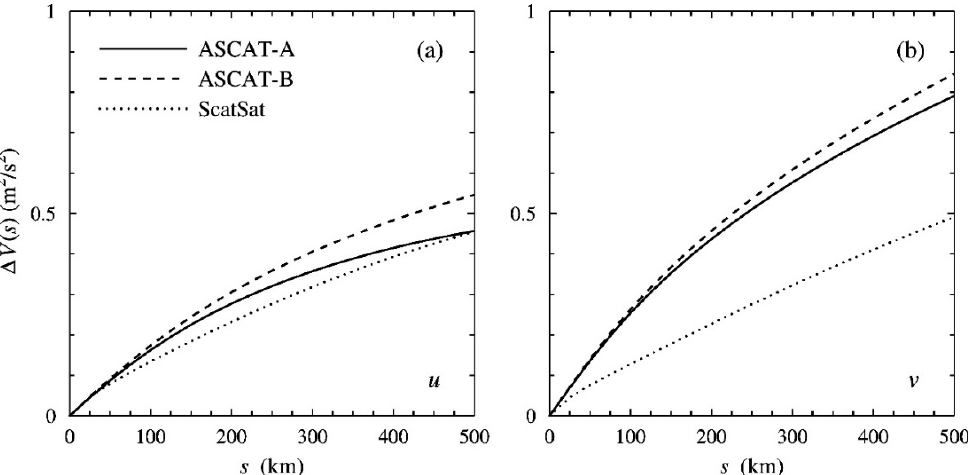
Figure 1. Difference between the spatial variance of ASCAT-A, ASCAT-B, and ScatSat and that of ECMWF, ∆ V ( s ) , as a function of s for the zonal wind component u ( a ) and for the meridional wind component v ( b